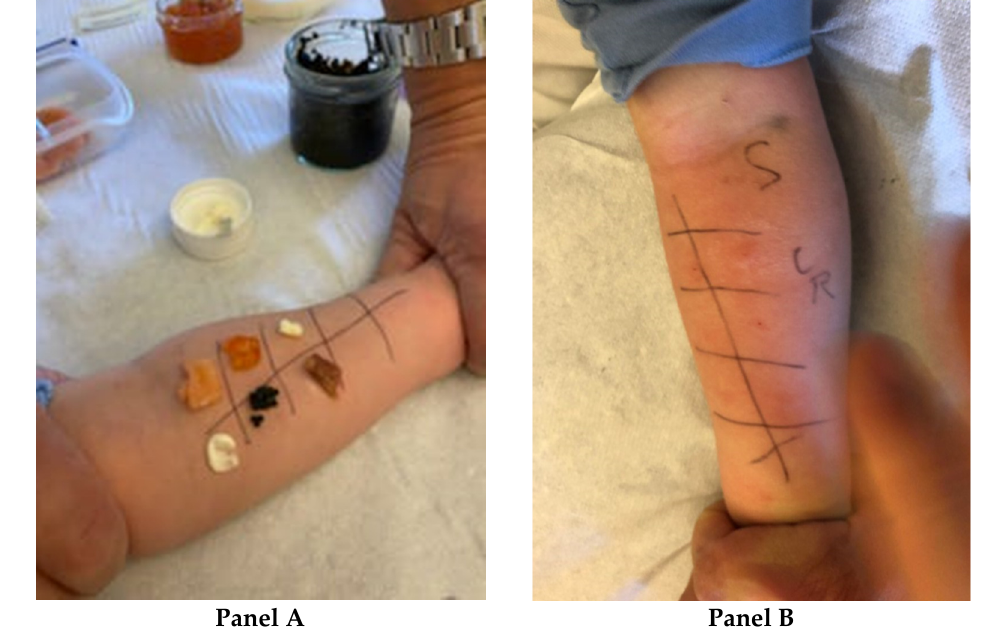
Figure 1. ( Panel A and Panel B ). Prick-by-prick tests performed on our patient. Prick-by-prick tests were performed for smoked salmon, anchovies, mayonnaise, salmon roe (red caviar), and lumpfish roe (Figure 1, Panel A ). Prick-by-prick tested positive for salmon roe (red caviar 11 mm × 10 mm) and lumpfish roe (4 mm × 4 mm), but negative for all the other foods tested (Figure 1, Panel B ). Positive (histamine) and negative (saline solution) controls were